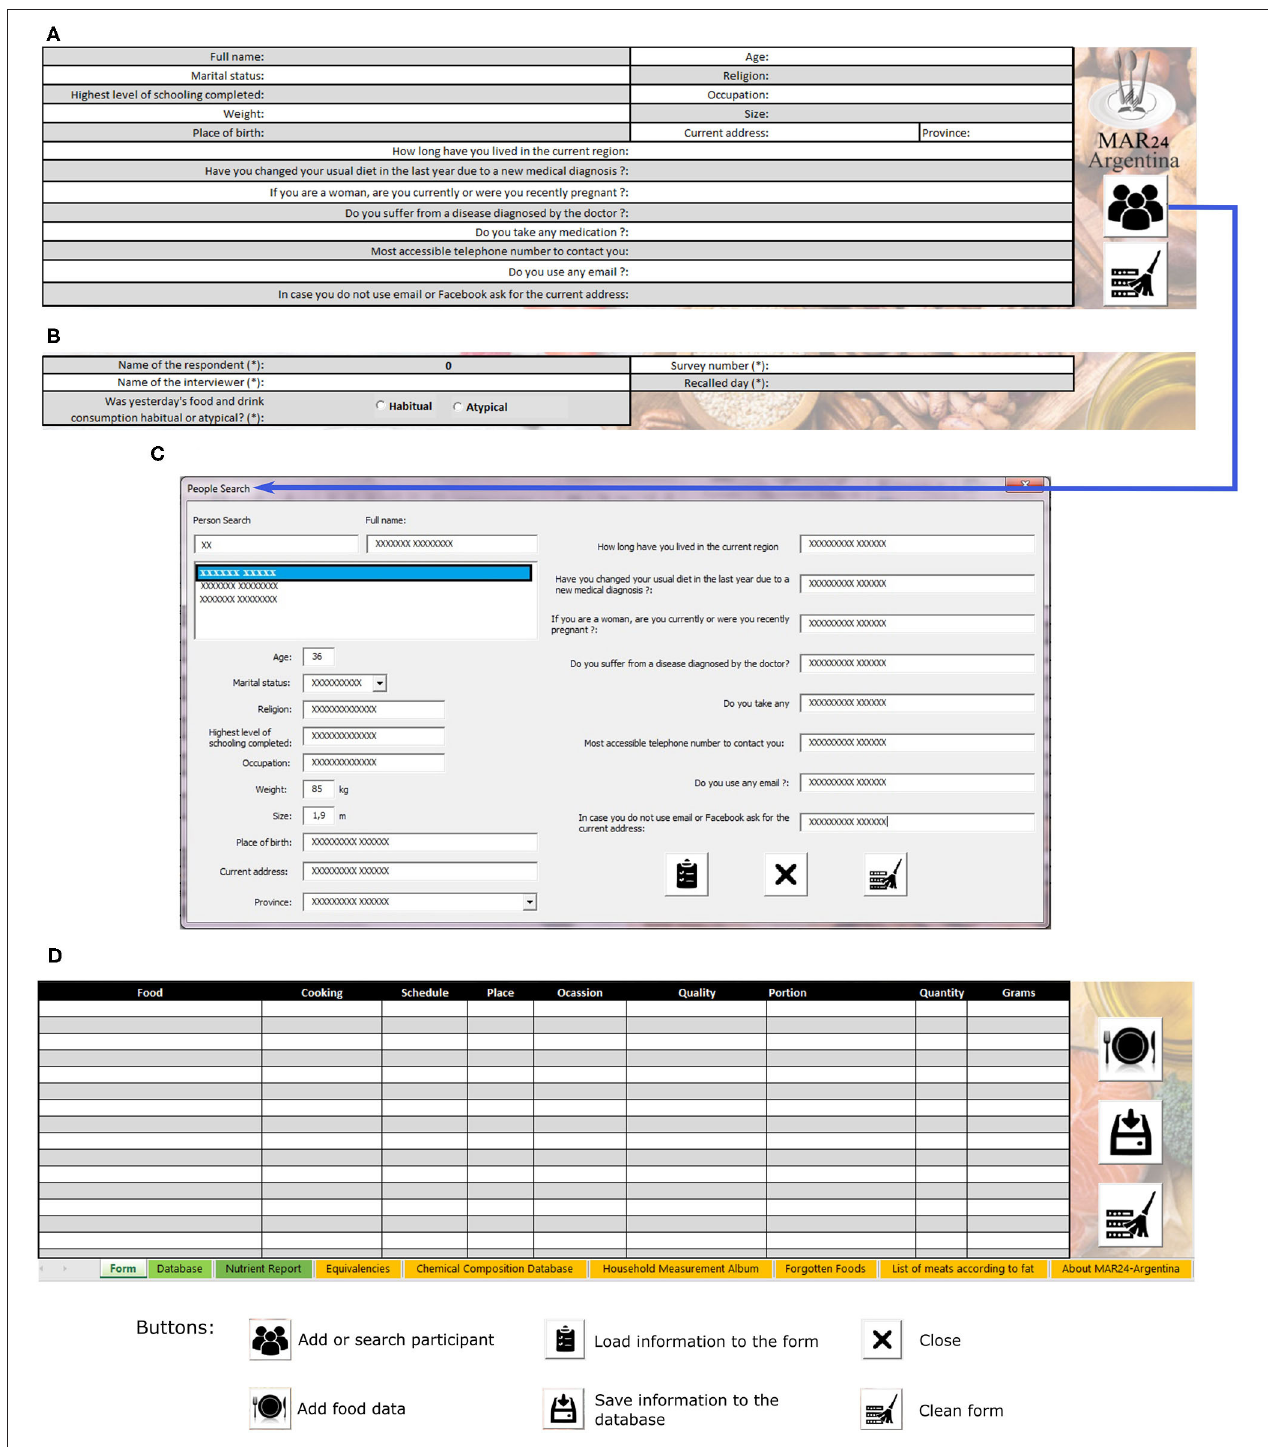
FIGURE 2 | Sections of the main form of the MAR24. (A) Interviewee data module with sociodemographic, health, and contact information; (B) Identification section of the 24-h dietary recall and interviewer; (C) Module for adding or searching participants; (D) Food data module resulting from the 24HR.